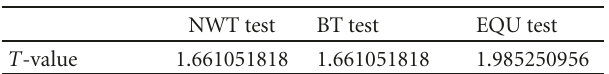
Table 11: T value.